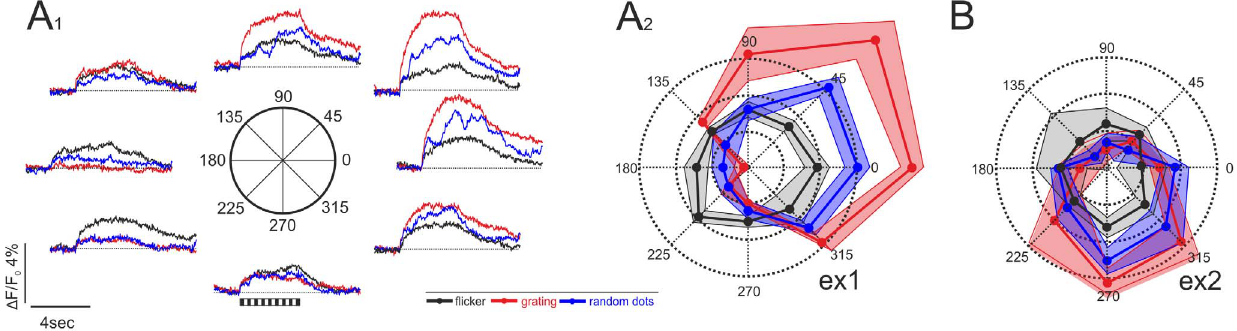
Figure 4. Responses of tectal neurons to three different types of visual stimuli. A 1 . Mean responses (n=3) to grating motion (red), motion of a random dot pattern (blue) and counterphase flicker of the grating (black) of the neuron shown in Figure 3 (ex1) in eight different directions (0 u – 315 u ). A 2 . Polar plots for the three different types of visual stimuli shown in A 1 . The plot shows the mean amplitude of the responses with the shaded areas indicating one standard deviation. The neuron had a clear and significant directional tuning for both, the moving random dot pattern (blue) and the moving grating (red), but was unselective for the orientation of the flicker stimulus. Throughout the figure, responses to grating motion are shown in red, responses to motion of the random dot pattern are shown in blue, and responses to counter-phase flicker are indicated in black. Note that for uniformity with the motion stimuli each of the four different flicker conditions is represented by pairs of opposite ‘‘directions’’, e.g. 0 u and 180 u both denote flicker of a grating with vertically oriented bars (compare Figure 1C). B . Example from a second neuron in the same preparation (see white square in Figure 3A, ex2). As in A 1 –A 2 , this cell was directionally selective but with a different preferred direction (290 u ) and was non-selective for the orientation of the flicker